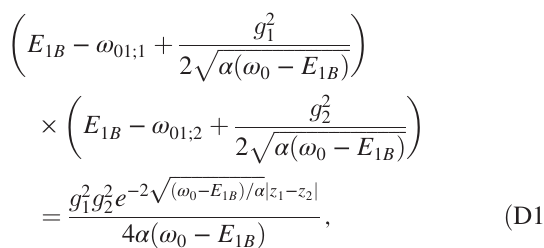
ffiffiffiffiffiffiffiffiffiffiffiffiffiffiffiffiffiffiffiffiffiffiffiffiffi α ð ω − E 0 1 B Þ